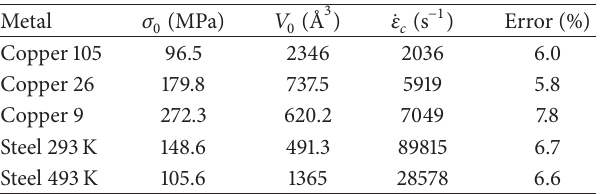
Table 7: Material constants and errors obtained by the modified- Eyring